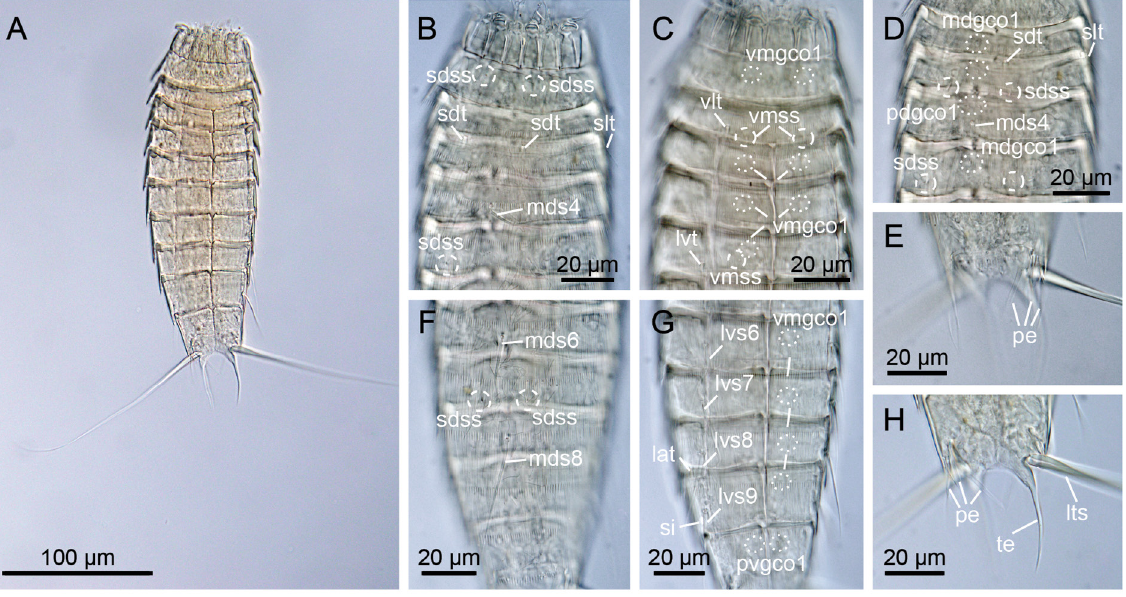
Fig. 33. Light micrographs showing overview and details of Echinoderes sp. aff. E. balerioni , ♂ (NHMD-921971). A . Ventral overview. B . Segments 1 to 5, dorsal view. C . Segments 1 to 5, ventral view. D . Segments 2 to 5, dorsal view. E . Segments 10 to 11, dorsal view. F . Segments 6 to 10, dorsal view. G . Segments 6 to 10, ventral view. H . Segments 10 to 11, ventral view. Abbreviations: see Material and